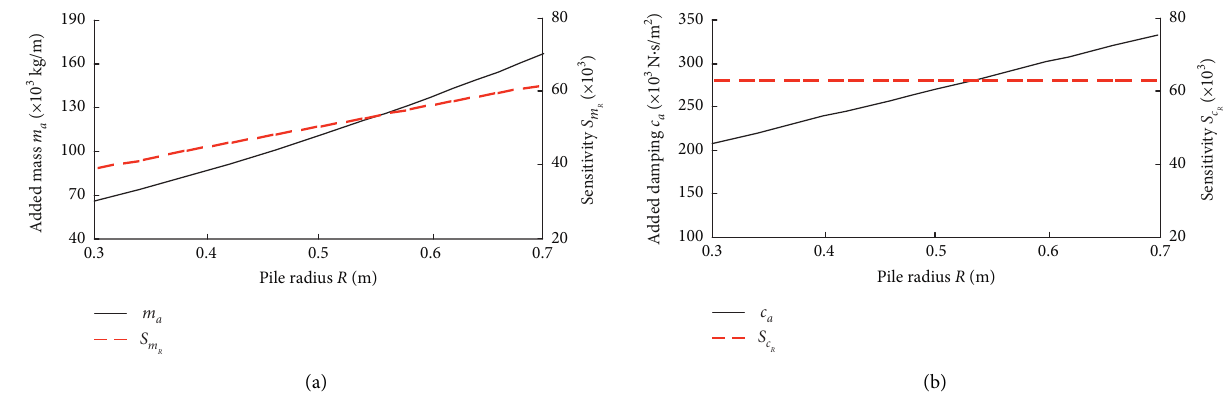
Figure 4: Influence of pile on the added mass (a) and added damping (b).